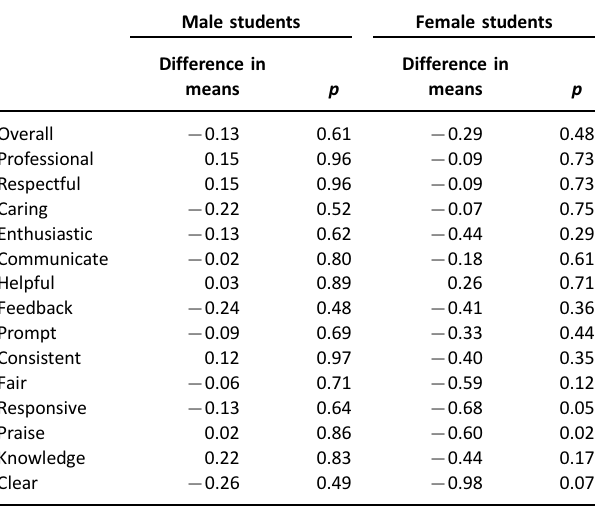
Table 10. SET and actual instructor gender (male minus female).